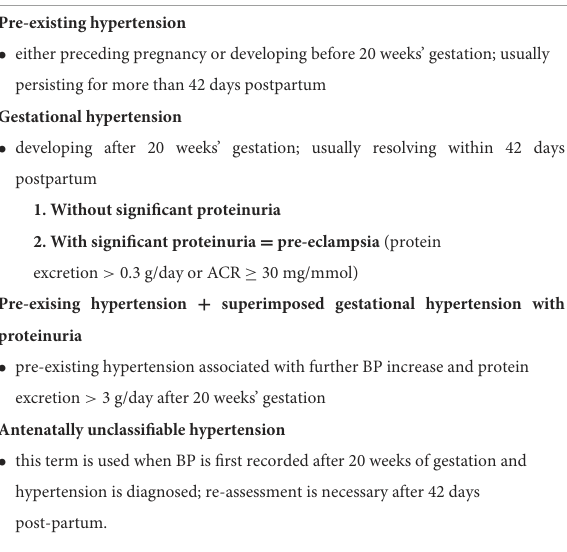
TABLE 2 Classification of hypertensive disorders of pregnancy by the 2018 ESC guidelines (67).